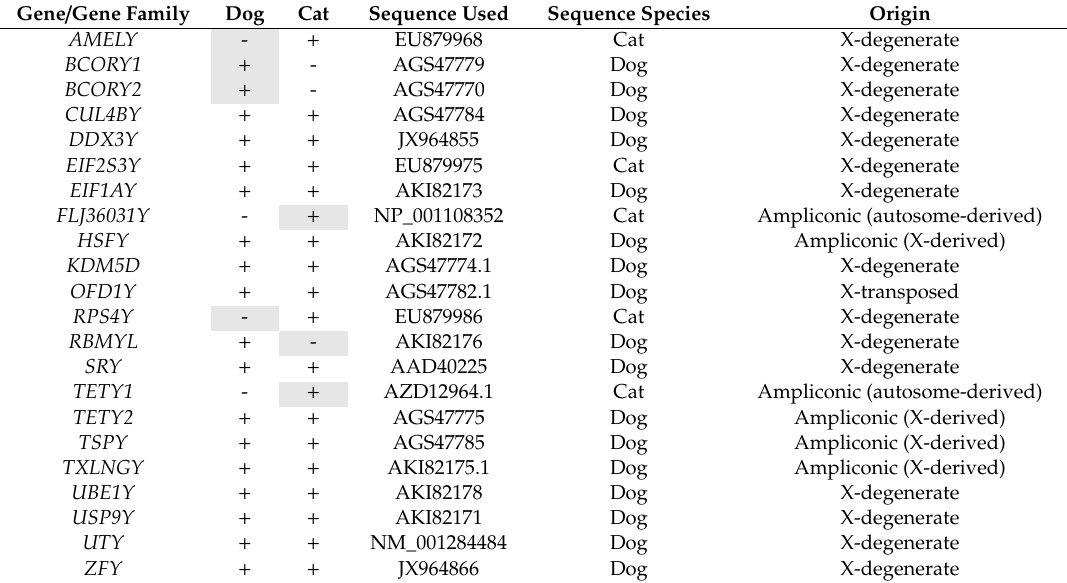
Table 1. The 22 genes of interest for the fox male-specific region of the Y-chromosome (MSY) based on cat and dog. Genes were selected as probes based on their presence on the MSY of dogs and / or cats [6,7,43]. Where a gene is present in one species and absent in the other, grey shading is used to highlight the derived state relative to other carnivores. The term ‘X-transposed’ denotes that OFD1Y may have been recently transposed from the X to the Y chromosome [44]. Evolutionary origins of genes in carnivores are based on analyses of the dog and cat Y-chromosomes [6,7,35]. The gene TXLNGY was previously called CYorf15 , and UBE1Y is also referred to as UBA1Y in the